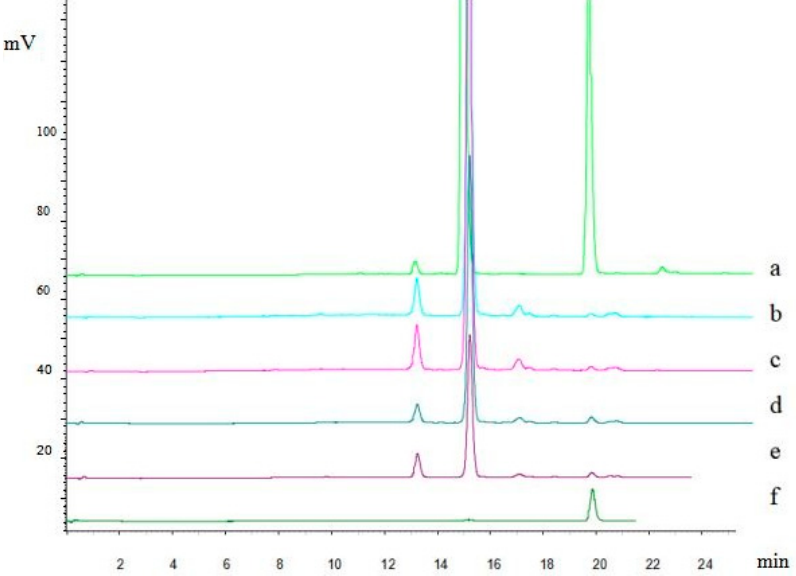
Figure 1. Chromatograms of different batch of flavonoids from Folium nelumbinis obtained by the osmosis extraction method (equivalent raw material 6 mg ml − 1 ). ( a )—Mixed standard solution of hyperoside and quercetin; ( b )—flavonoids (batch No. 160525); ( c )—flavonoids (batch No.160528); ( d )—flavonoids (batch No.160523); ( e )—flavonoids (batch No.160528); ( f )—standard solution of quercetin.